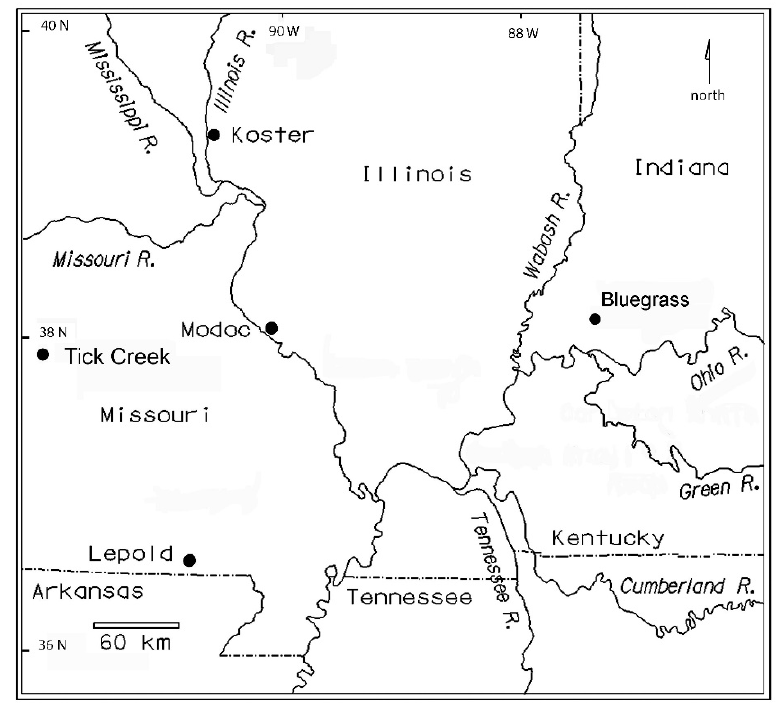
Figure 1. Location of Lepold site and others in central Mississippi